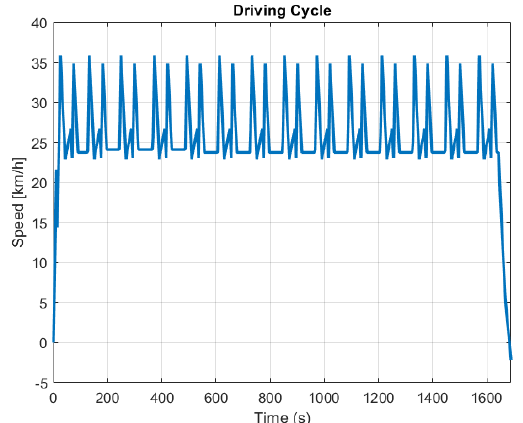
Figure 8. Recorded speed profile (driving cycle) during the 2017 Brazilian edition of the Shell Eco-marathon